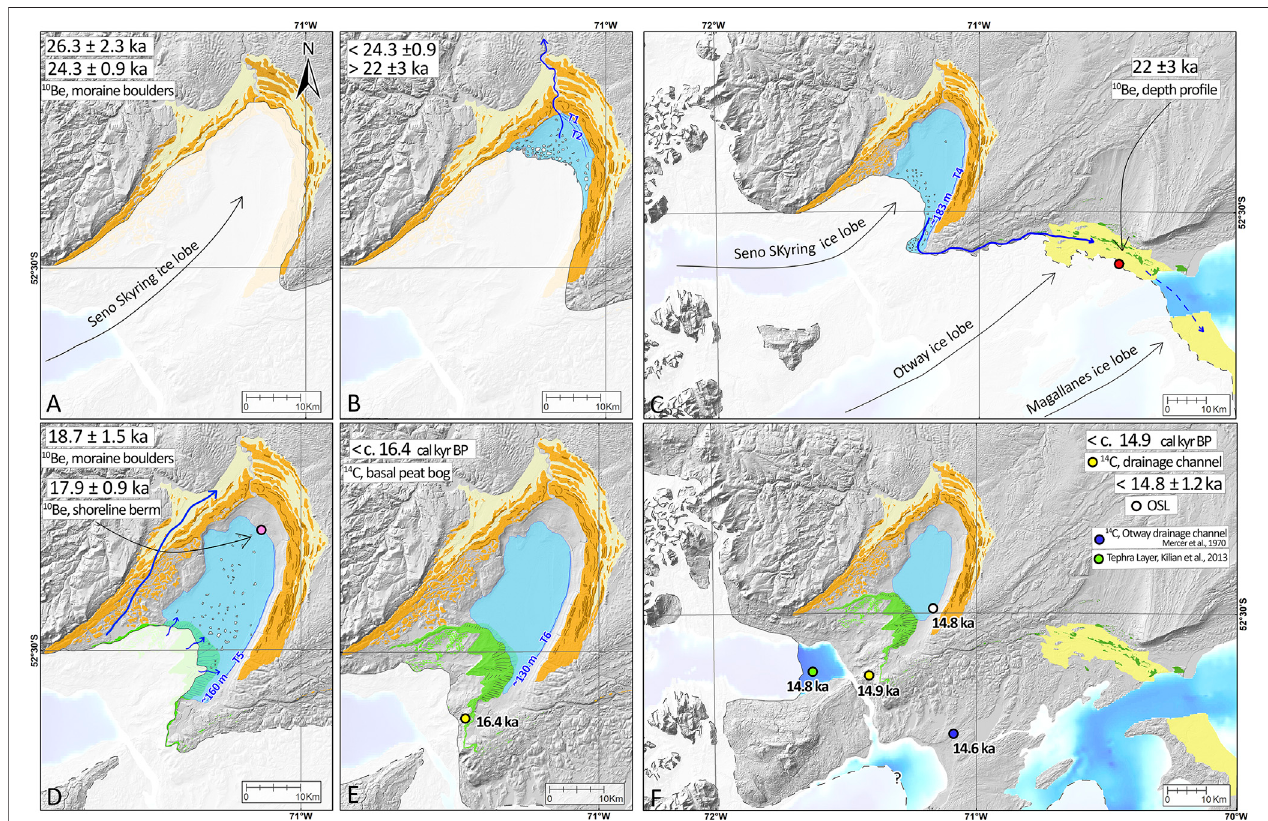
FIGURE 11 | Evolution of the former Seno Skyring ice lobe. (A) Glacier position during the deposition of LB III and LB IV moraines. (B) Formation of the Laguna Blanca proglacial lake with a northern spillway. During this period, the northern spillway served as drainage for T1 and T2 lake levels. (C) Abrupt (partial) drainage of LagunaBlancatothesoutheastreachingthe Otwayloberegion, lakelevel decreased rapidlyfrom T3toT4. (D) Glacierposition duringthedepositionofRVmoraine; the frontal parts formed sub-aqueously under the lake level T5. During this glacial advance/stillstand, the outwash from LB moraines was reactivated at 20.6 ka. (E) MinimumageoftheglacierabandonmentfromRVmoraineposition. (F) TheSenoSkyringandOtwaylobesretreatedbacktopositionsintothefjords,evidencedbyland expositionandposteriordepositionoforganicmaterialandtephraontop.Atthesametime,OSLdatingoflacustrinesedimentsfromthepalaeoLagunaBlancaindicates ahighstandofthelakelevelbetweenT5andT6.Notethattheshorelinealtitudes ofthepalaeo LagunaBlancaarefrommeasurements takenatthesoutheasternareaof the basin. Dashed lines around ice edges correspond to inferred limits.